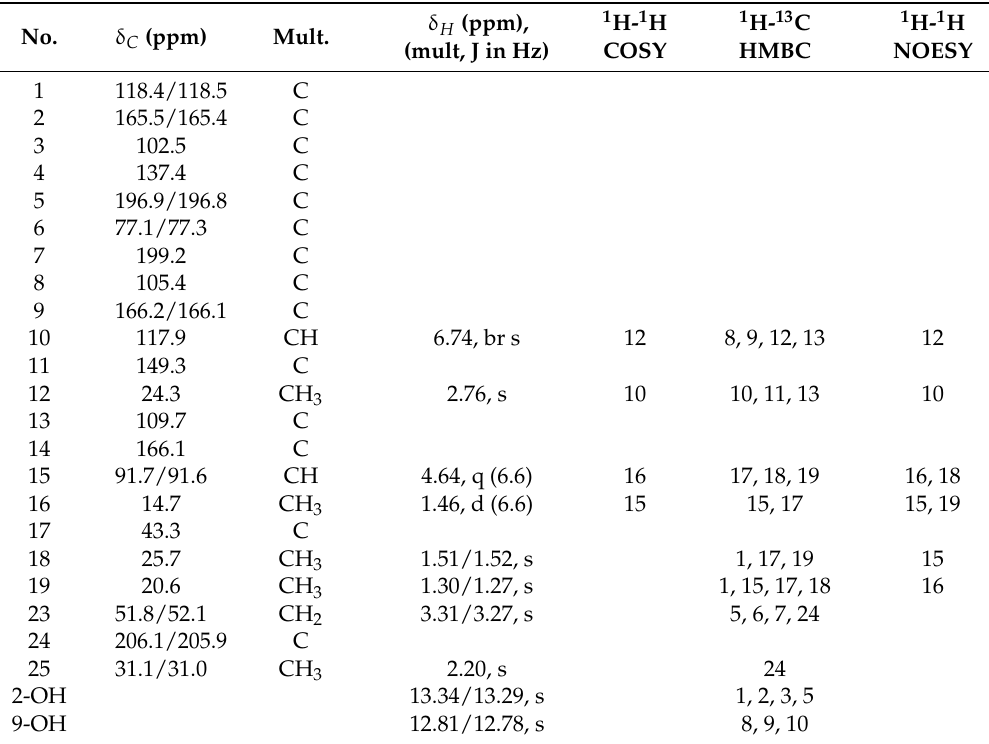
Table 4. NMR (CDCl 3 ) spectroscopic data for